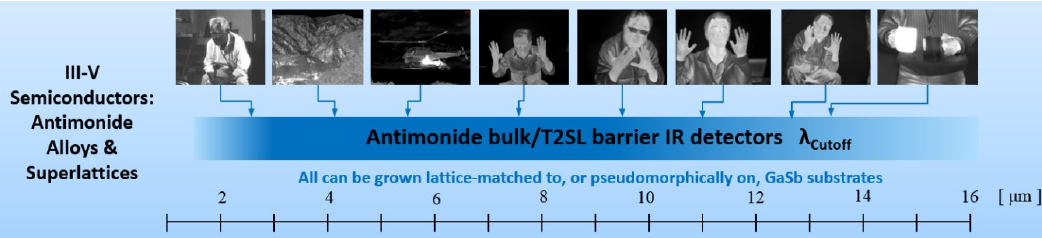
Figure 61. Images from JPL antimonide bulk and T2SLs barrier FPAs with λ cut-off in wide IR range (after [159]).